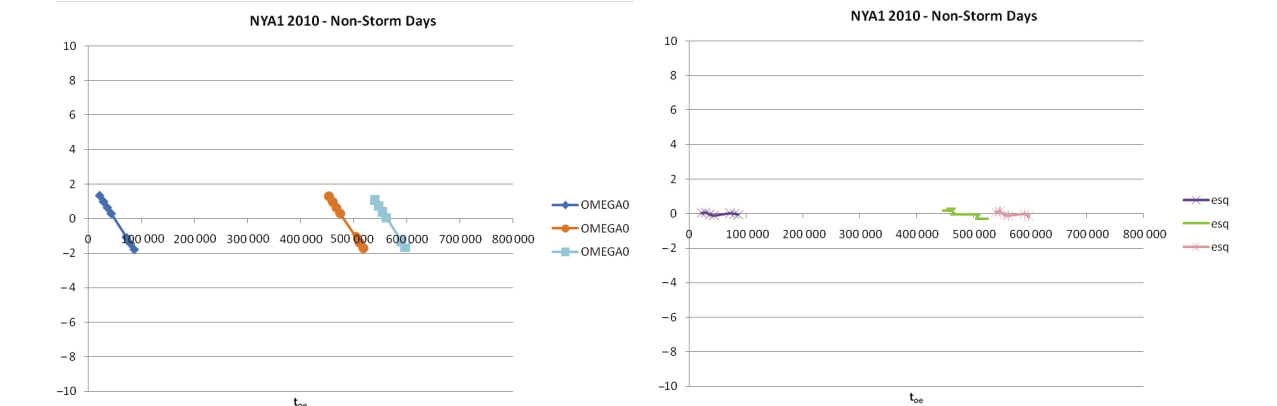
Fig. 16. Right ascension of the ascending node during three stormless days in 2010 using cPOS stations (NYa1)